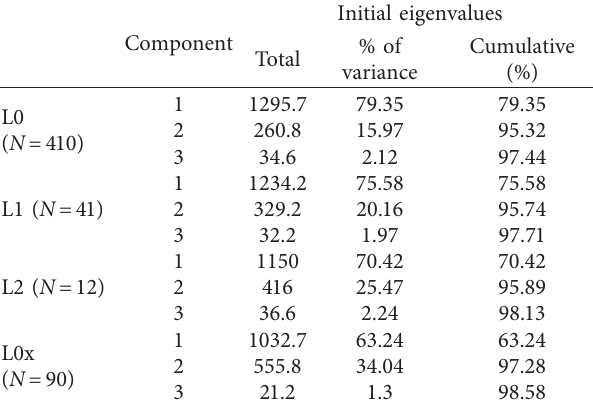
Table 6: Summary of the principal component